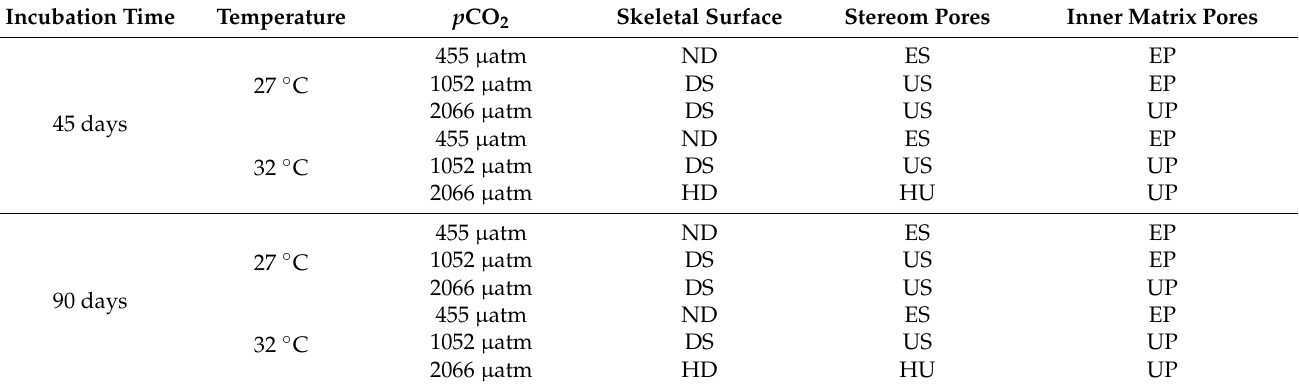
Table 3. Skeletal microstructure characteristics of A. yairi under crossed temperatures and p CO 2 conditions at different incubation times as observed with scanning electron microscopy